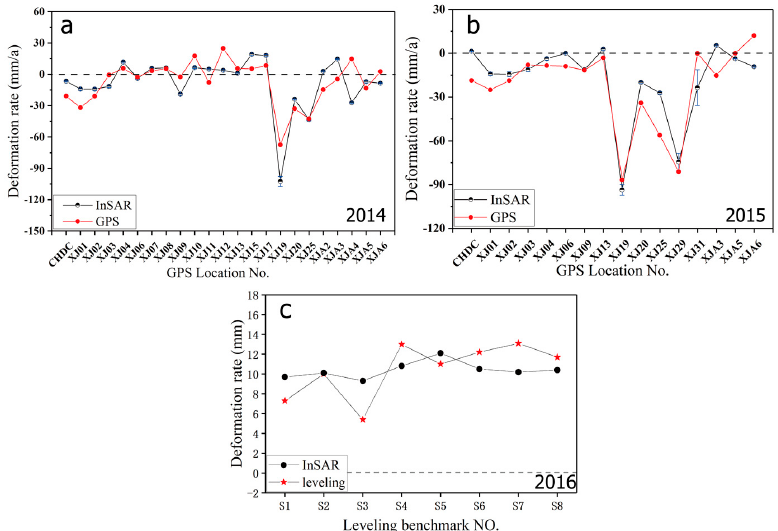
Figure 5. Comparison of InSAR measurements with GPS and leveling measurements. ( a ) With GPS measurement in 2014; ( b ) with GPS measurement in 2015; ( c ) with leveling measurement in 2016. The error bar, with one standard deviation, is shown in ( a , b ) at each GPS benchmark.